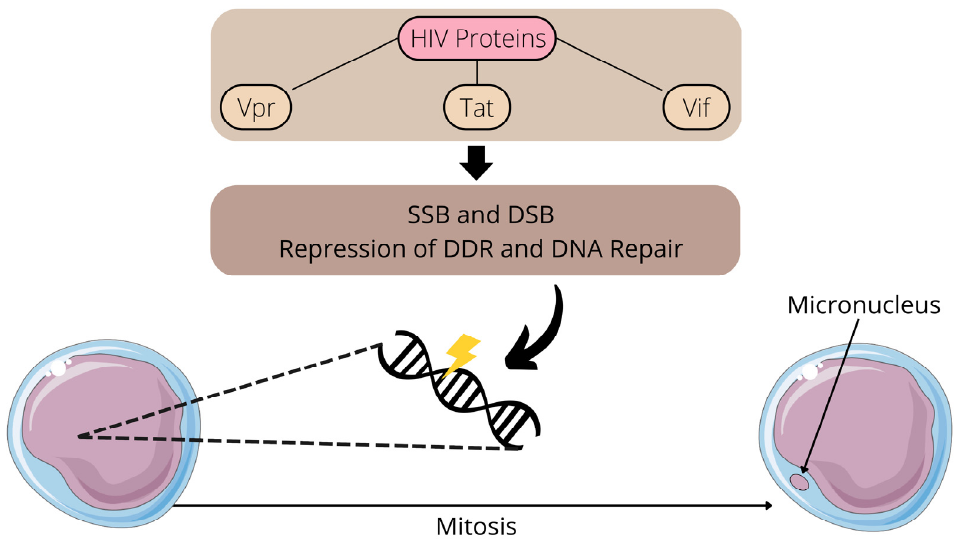
Figure 1. Effects of HIV proteins on DNA integrity and micronucleus formation. SSB: single-strand DNA break; DSB: double-strand DNA break; DDR: DNA damage response.